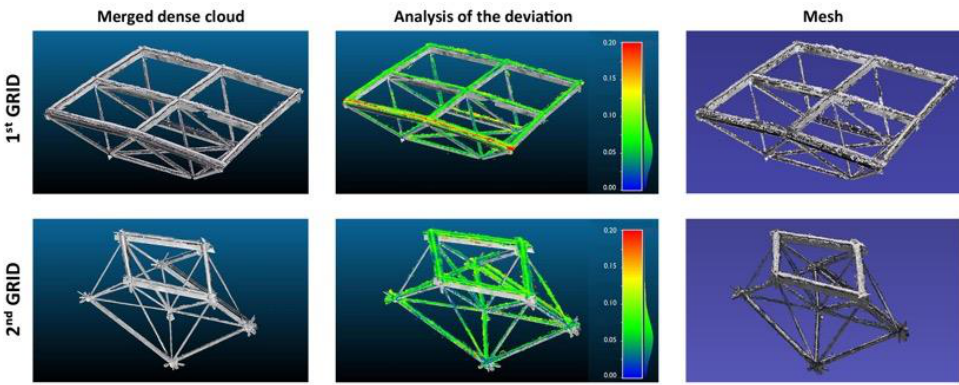
Figure 34. The TLS and RPAS merged dense clouds for the two grids, with respective analysis of the deviation and reconstructed mesh.